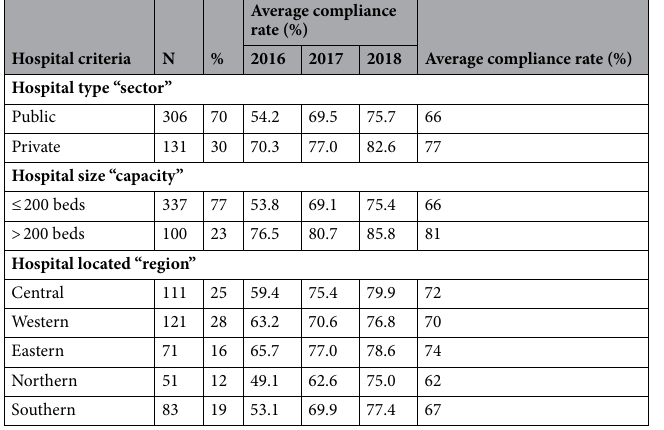
Table 2. Distribution of hospital characteristics by number and percentage of the study population and by compliance rate per